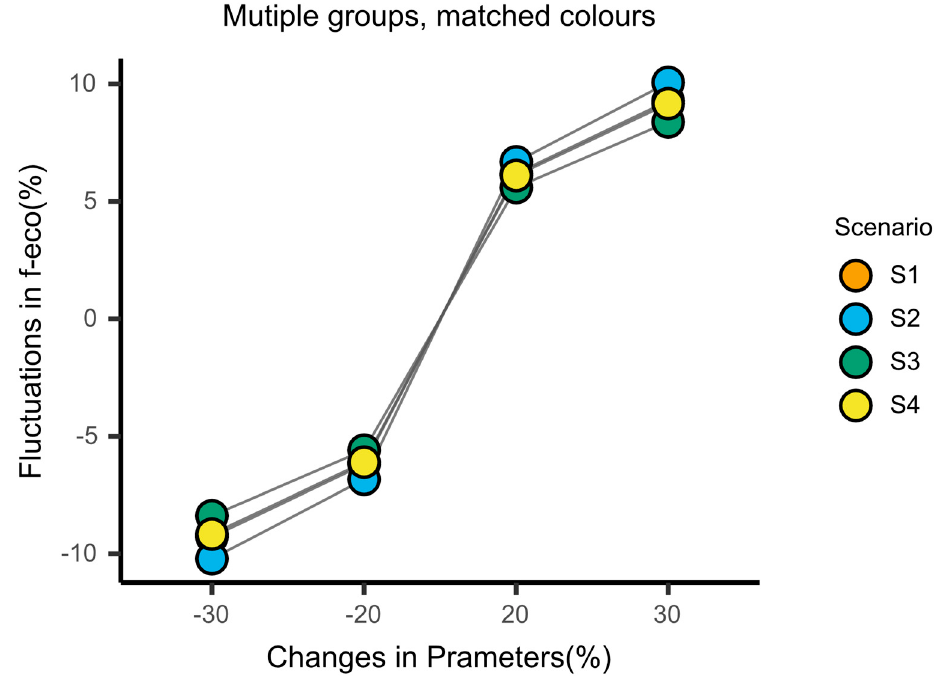
Figure 7. Sensitivity analysis of the f eco by changing parameters.